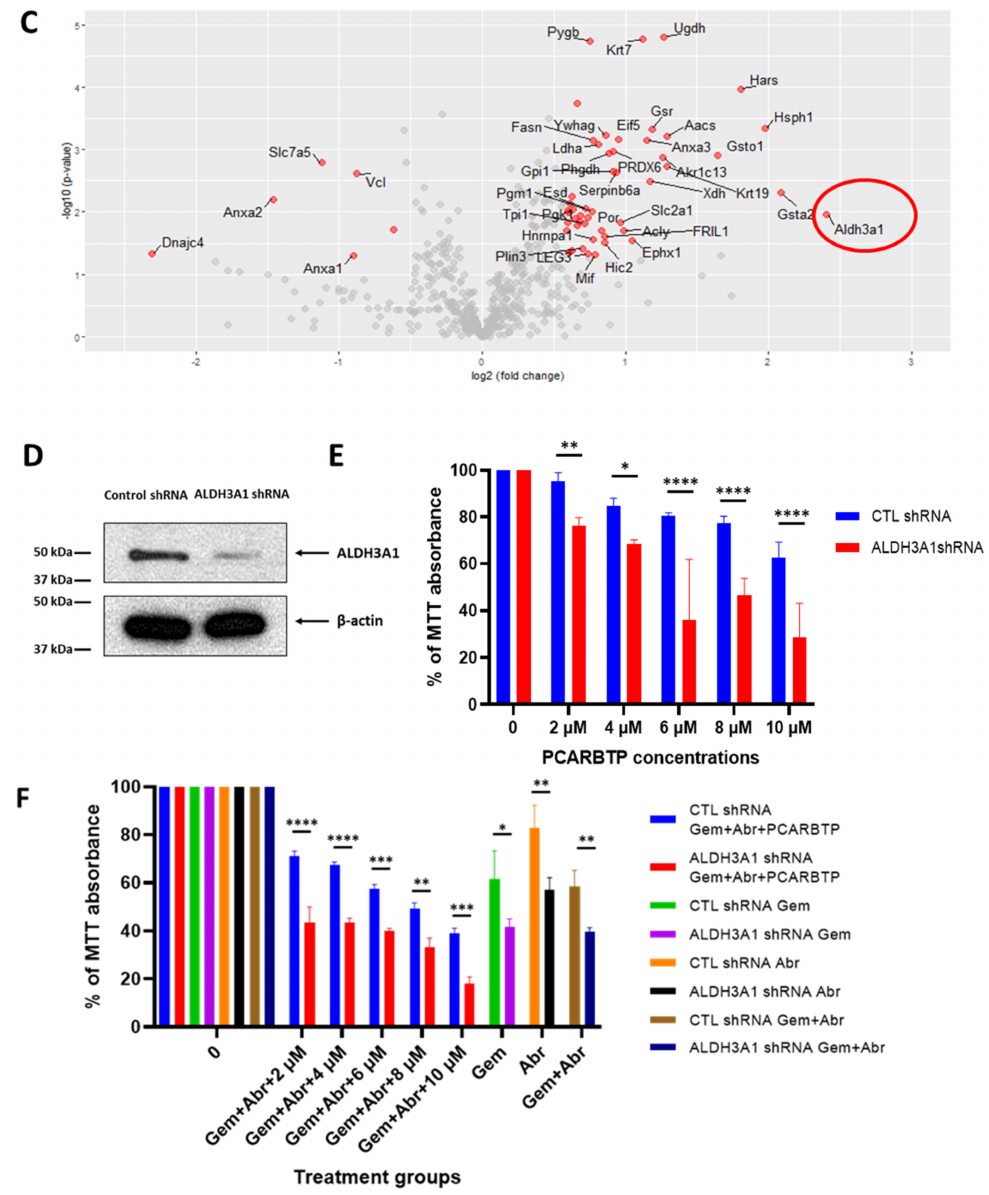
Figure 9. Drug resistance to PCARBTP in cultured Pan02 cells. ( A ) Proteomic analysis of protein changes in PCARBTP resistant clones. Heatmap of unbiased clustering of only the significant proteins, 135 proteins with ANOVA p < 0.05 (color in Log2-scale), n = 3. ( B ) STRING analysis showing the following enriched KEGG pathway-linked proteins. Number of nodes: 45; number of edges: 89; average node degree: 3.96; avg. local clustering coefficient: 0.521; expected number of edges: 23; PPI enrichment p -value < 1.0 × 10 − 16 . KEGG pathways: light green: Glycolysis/Gluconeogenesis (hsa00010) ( p value 3.45 × 10 − 8 ); yellow: metabolic pathways (hsa01100) ( p value 4.26 × 10 − 7 ); light blue: carbon metabolism (hsa01200) ( p value 1.08 × 10 − 5 ); dark green biosynthesis of amino acids (hsa01230) ( p value 2.10 × 10 − 5 ); magenta: HIF-1 signaling pathway (hsa04066) ( p value 7.12 × 10 − 5 ); red: metabolism of xenobiotics by cytochrome P450 (hsa00980) ( p value 0.00039); dark blue: glutathione metabolism (hsa00480) ( p value 0.0029). ( C ) Volcano plot analysis for significant up/down regulated proteins (PCARBTP/Pan02_control), ALDH3A1 in red circle is the most upreg- ulated protein. ( D ) Western blot showed ALDH3A1 was knocked down by ALDH3A1 lentiviral shRNA. ( E , F ) MTT assay performed on Pan02 cells transfected with control shRNA and ALDH3A1 shRNA then treated with PCARBTP/PAPTP or combined with 0.25 µ M of Gemcitabine and 20 nM of Abraxane as indicated ( n = 3, mean ± SD), * p < 0.05; ** p < 0.01, *** p < 0.0005, **** p <